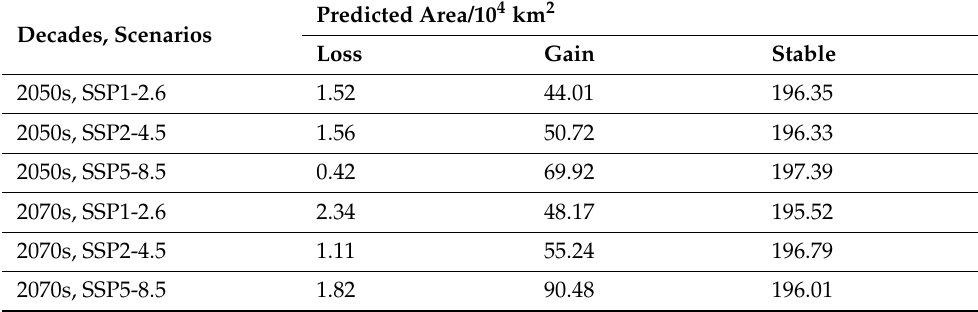
Table 4. Future changes in suitable habitat